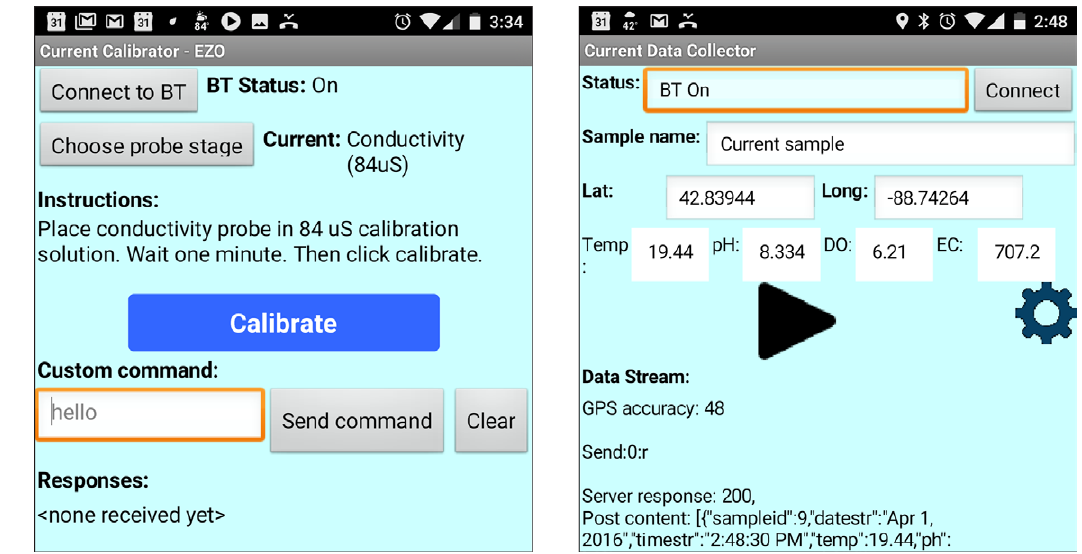
Figure 4: App screens for both the Android calibration app (left) and field collector app